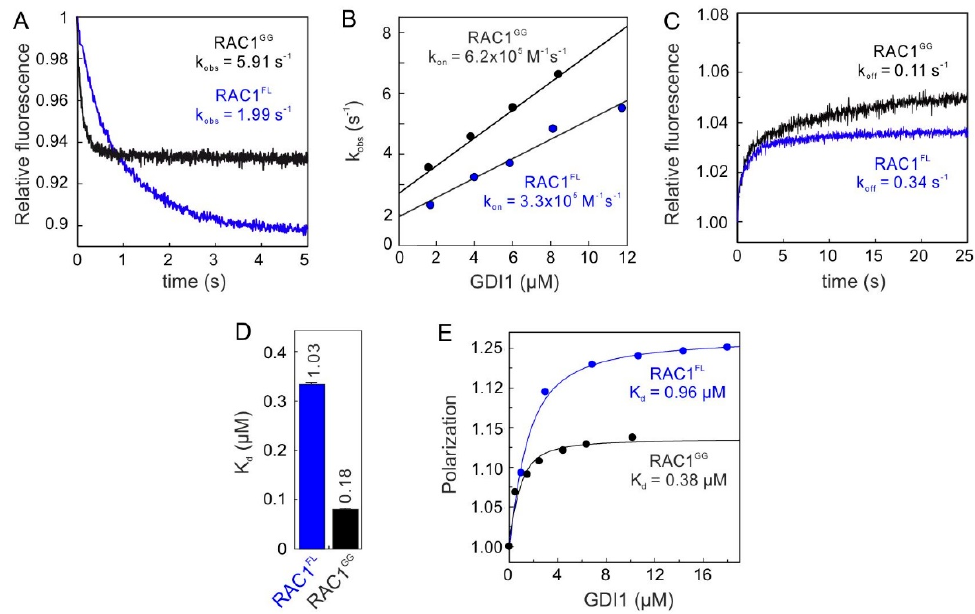
Figure 1. RAC1 GG and RAC1 FL bind with a similar affinity to GDI1. ( A ) Association of GDI1 (4 µM) with RAC1 GG and non-isoprenylated RAC1 FL (0.2 µM, respectively). ( B – D ) Quantitative measure- ments of GDI1 interaction with RAC1 GG and RAC1 FL led to the calculation of the individual binding constants, association rate constant or k on ( B ), dissociation rate constant or k off ( C ), and dissociation constant or K d directly from the k off /k on ratio ( D ). ( E ) Titration of increasing GDI1 concentrations to RAC1 GG and non-isoprenylated RAC1 FL (0.2 µM, respectively), using fluorescence polarization, re- sulted in the determination of the equilibrium K d values.